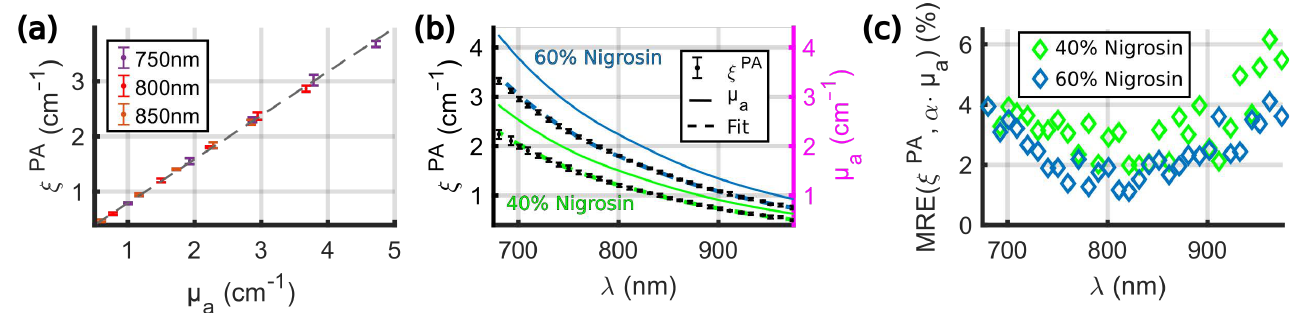
Figure 6. Linearity of the PA spectrometer with respect to the absorption coefficient µ a and at different wavelengths. ξ PA was computed for the 5 percent solutions of nigrosin and for 4 acquisitions in 4 tubes for each solution. ( a ) ξ PA values (median ± MAD) as a function of µ a for 3 different wavelengths and the 5 solutions. The dashed line is a fit by a homogeneous linear function of slope 0.79. ( b ) The left axis corresponds to ξ PA values (median ± MAD) as a function of the optical wavelength for two solutions: 40% and 60% of the stock solution. The absorption spectra µ a are displayed (right axis, solid line), as well as the fits. The proportionality factors were α 40% = 0.81 and α 60% = 0.80, respectively. ( c ) MRE of ξ PA with α · µ a as a reference for the 40% and 60% percent